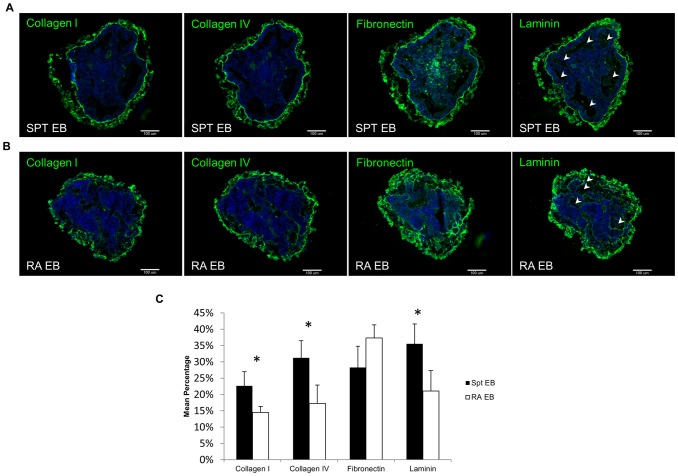
ECM characterization of native EBs resulting from different treatment - SPT vs. RA.Immunofluorescence images of both groups of EBs – (A) SPT and (B) RA composing ECM molecules. Arrow heads indicate more cavities were found within the SPT EBs than the RA EBs. (C) Metamorph image analysis showing the quantification of the mean fluorescence intensity (MFI) of ECM markers stained in both group of EBs. Bar = 100 µm. All values are mean ± SD, p<0.05 (*), n = 6, represents pooled of EBs from 6 experimental repeats.